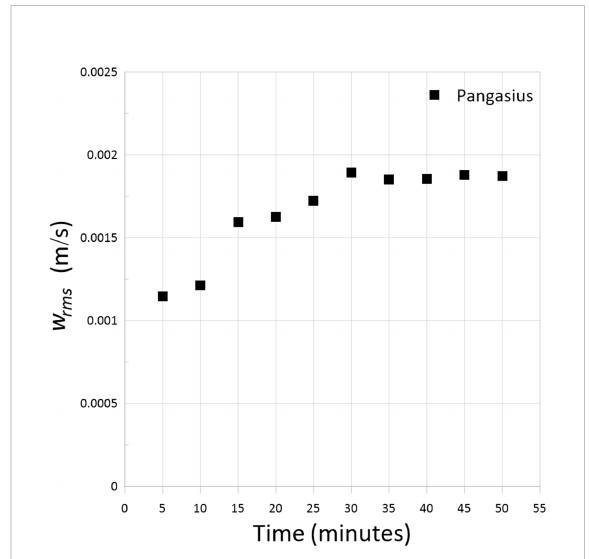
FIGURE 2 RMS velocity as a function of data record length at the presence of pangasius school at the abundance of 50 animal/m 3